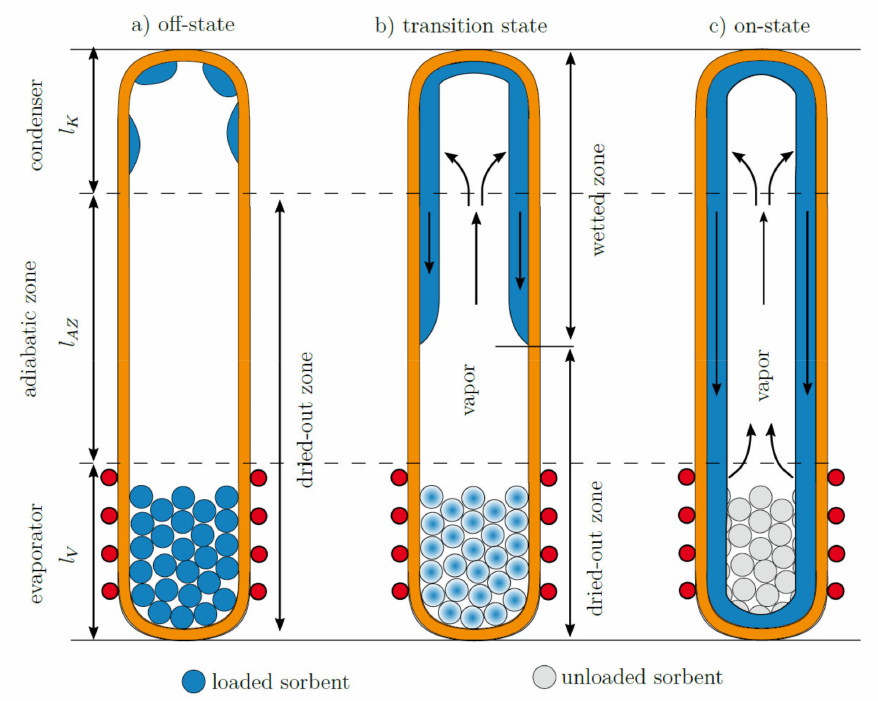
Figure 6. Operating regimes of heat switch. ( a ) No water has yet desorbed from the sorbent and no latent heat transport is taking place (off-state). ( b ) Some water has desorbed from the sorbent and increasingly wets the adiabatic zone. In the wetted area, latent heat transport can take place. The thermal resistance is changing continuously in dependence of the length of the wetted zone (transition state). ( c ) The majority of the heat switch is wetted and can sustain latent heat transport